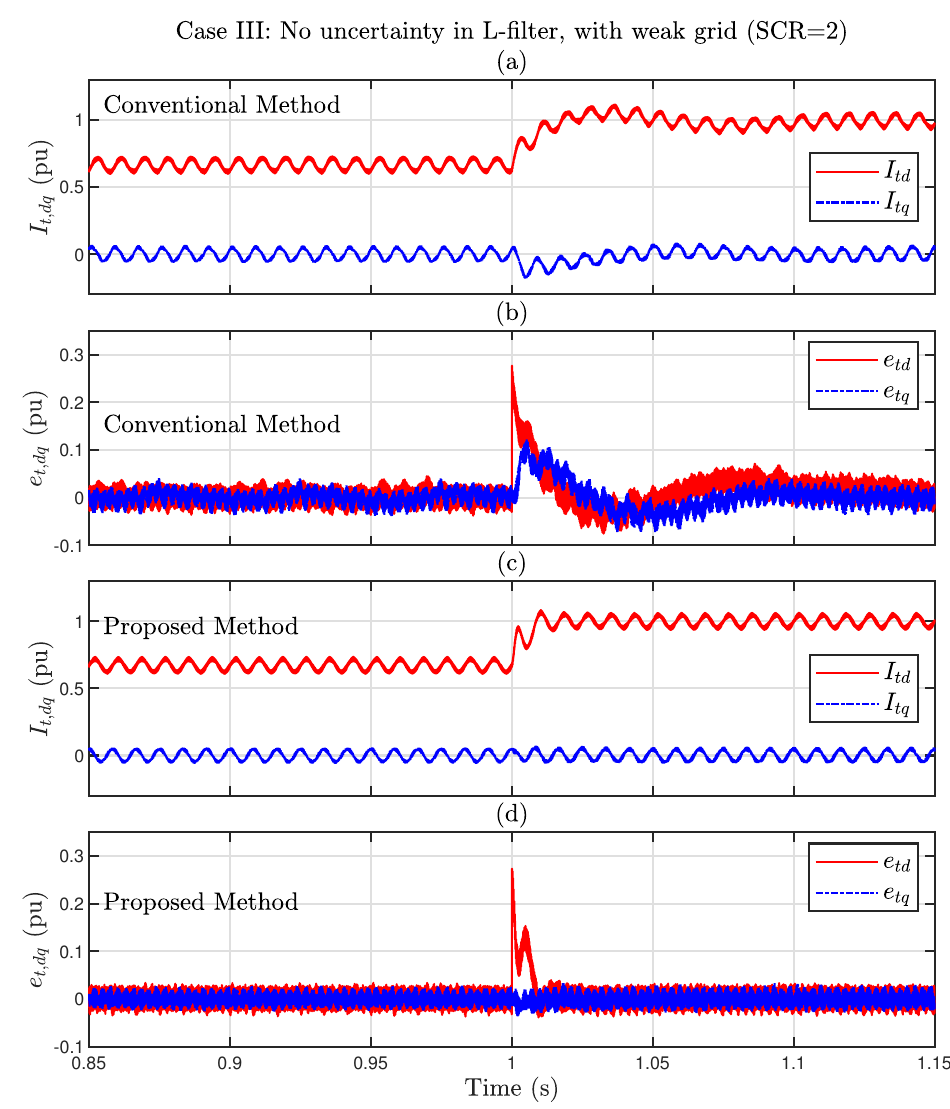
Figure 18. Comparison of the results for Case III: dq components of the inverter currents ( I t , dq ) and error signals ( e t , dq ): ( a , b ) conventional method, and ( c , d ) proposed